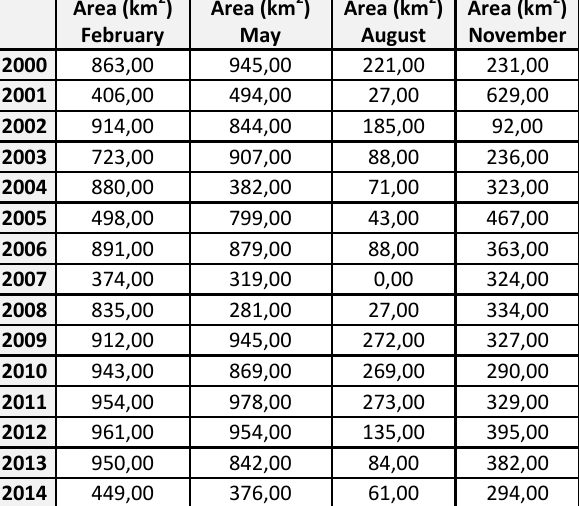
Table 1. Salt Lake Surface Area for each month and